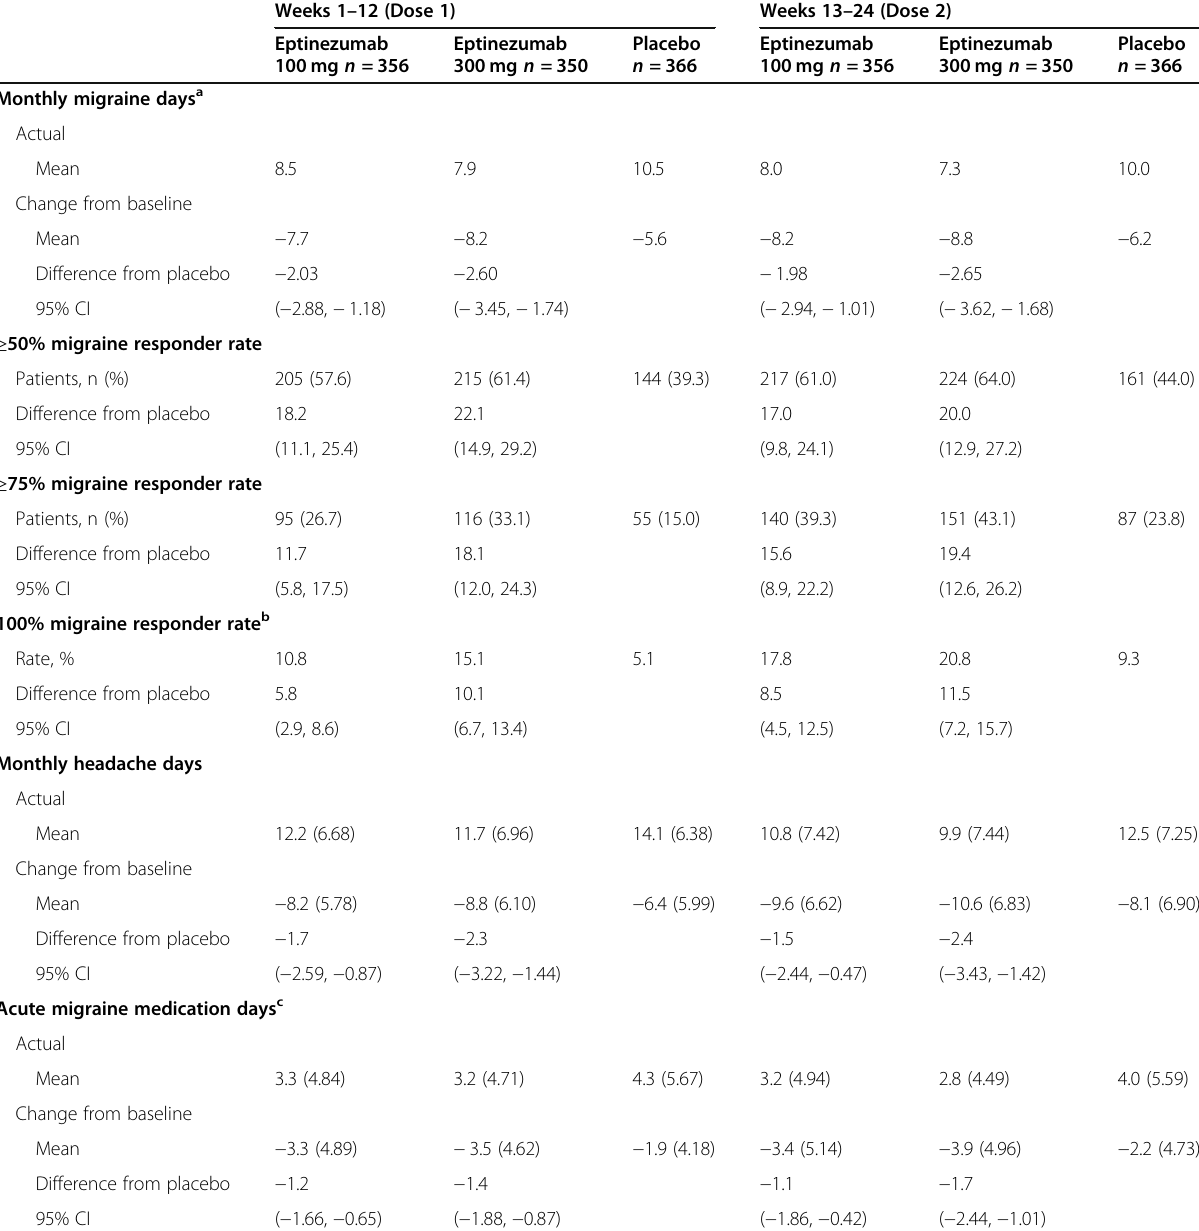
Table 1 Efficacy outcomes (efficacy population) Weeks 1 – 12 (Dose